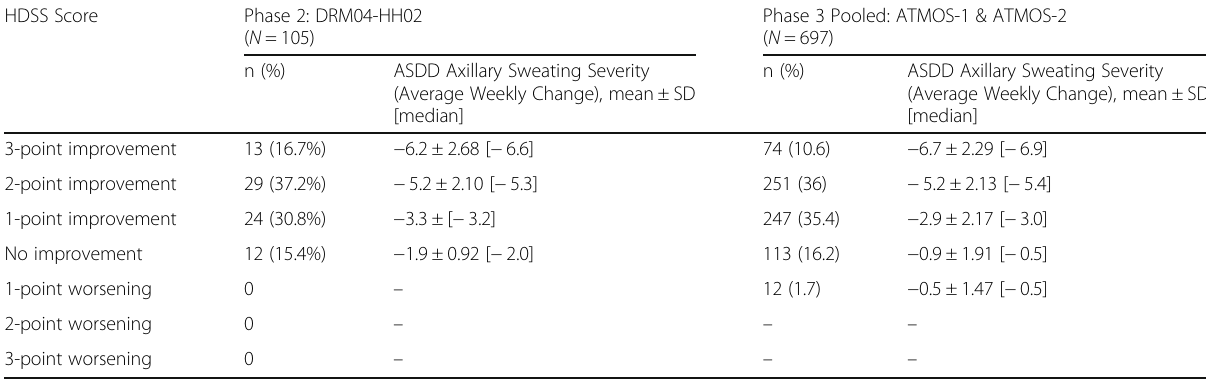
Table 8 ASDD Change Scores Across HDSS